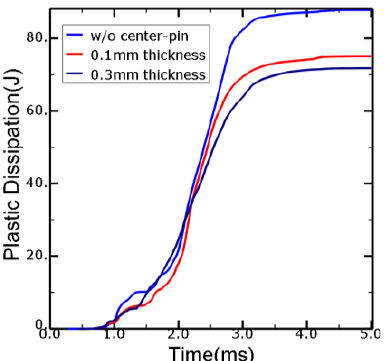
Figure 6. Plastic dissipation comparison plot in a roll of a separator for without, 0.1 and 0.3 mm-thick center-pin cases, respectively.